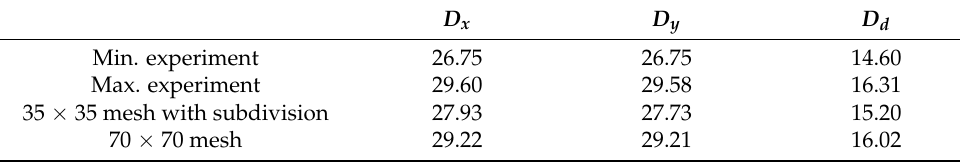
Table 1. Draw-in results for comparison (units in mm).